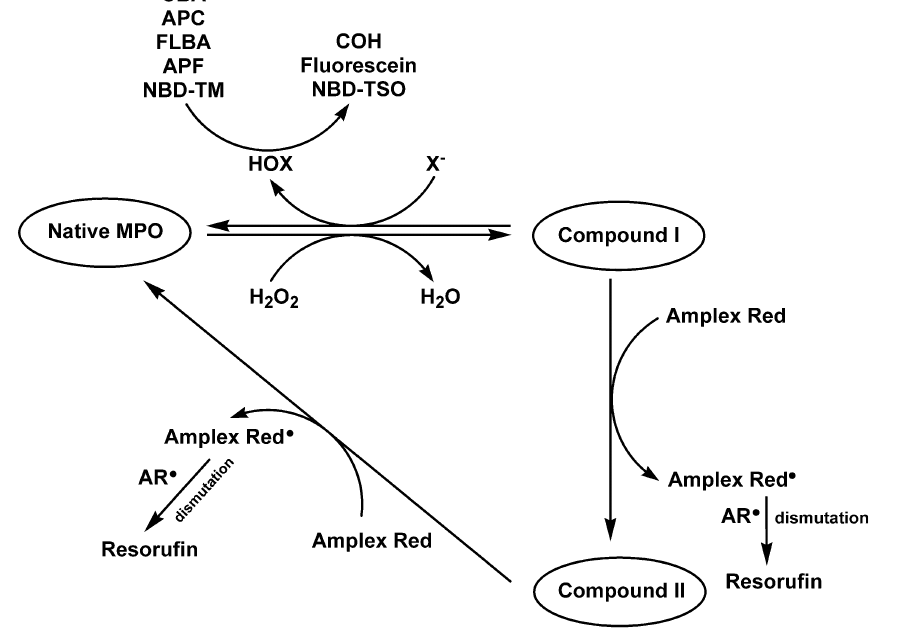
Figure 1. Redox cycles of MPO and methods of their